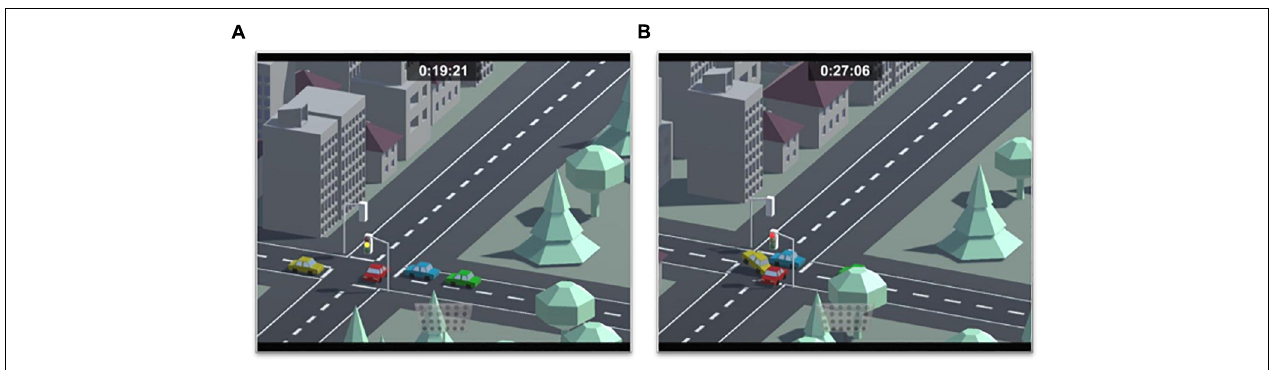
FIGURE 3 | Illustration of the simulated driving task, the STOPLIGHT task, in which participants had to decide to break on or to overrun yellow traffic lights on a simulated track. Outcome options are either to lose a safe amount of time (STOP) or to gamble between losing no time (safe GO-decision, A ) and causing an accident (B)